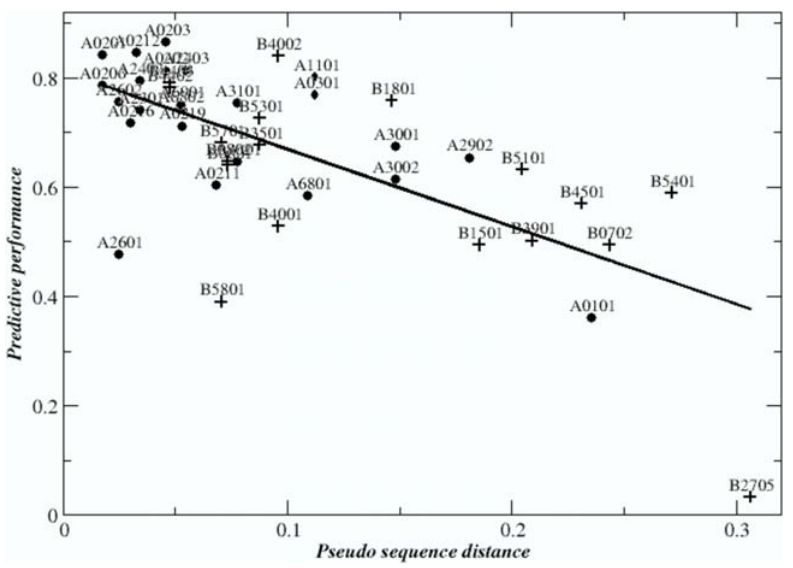
Figure 2. Predictive performance of the NetMHCpanmethod as a function of the distance to its nearest neighbor HLA allele. The nearest neighbor distance is estimated from the alignment score of the HLA pseudo sequences using the relation d ~ 1 { BLOSUM50 alignment score [47] between the pseudo sequences for alleles A and B, respectively. HLA-A alleles are shown as solid circles. HLA-B alleles are shown as + . The Pearson correlation coefficient between the pseudo sequence distance and the predictive performance for the 42 HLA alleles included in the plot is 0.67. Note, that the distance measure inherently assumes that all residues are equally important and independent of the pseudo sequence context. While this assumption is obviously inconsistent with the reality of primary anchors, it meets another essential requirement; it is simple and unbiased.